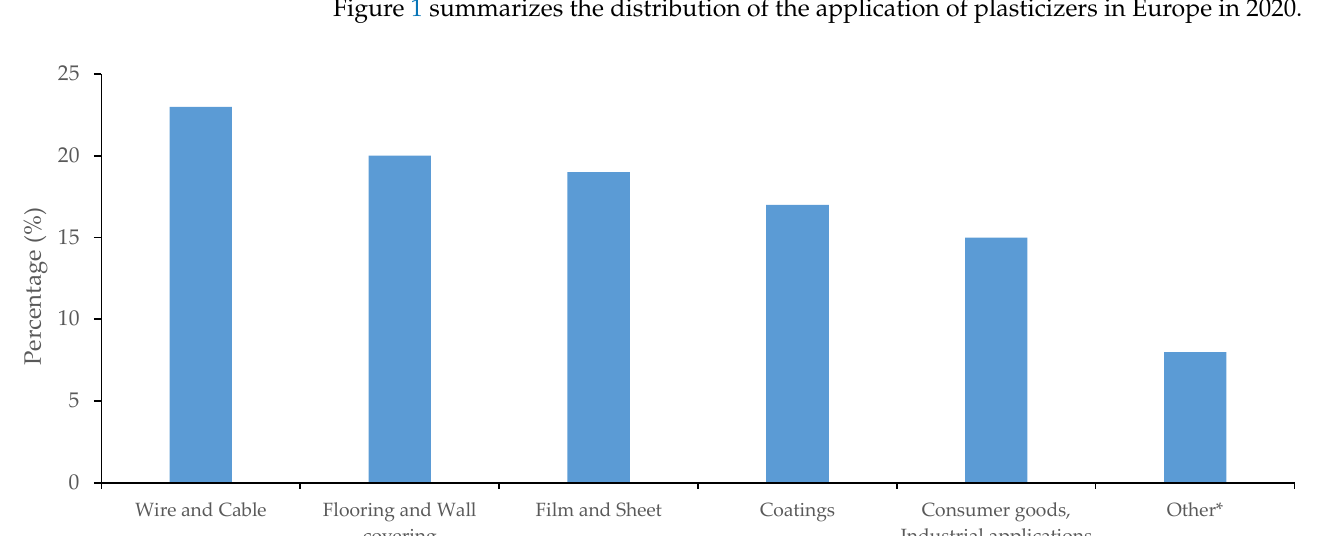
Figure 1. Average distribution of plasticizers use in Europe (2020). Other*: surface coatings, rubber compounds, medical applications, and elastomers (Source: 2020 IHS and European Plasticizers estimates).